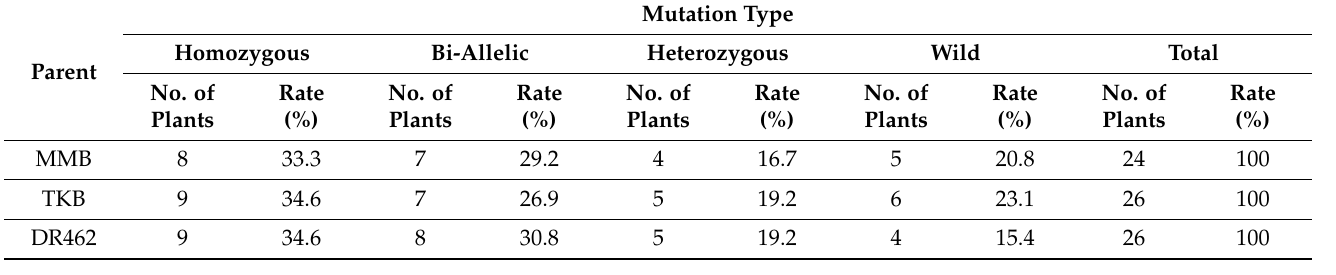
Table 1. Analysis of mutation types in the T 0 generation.